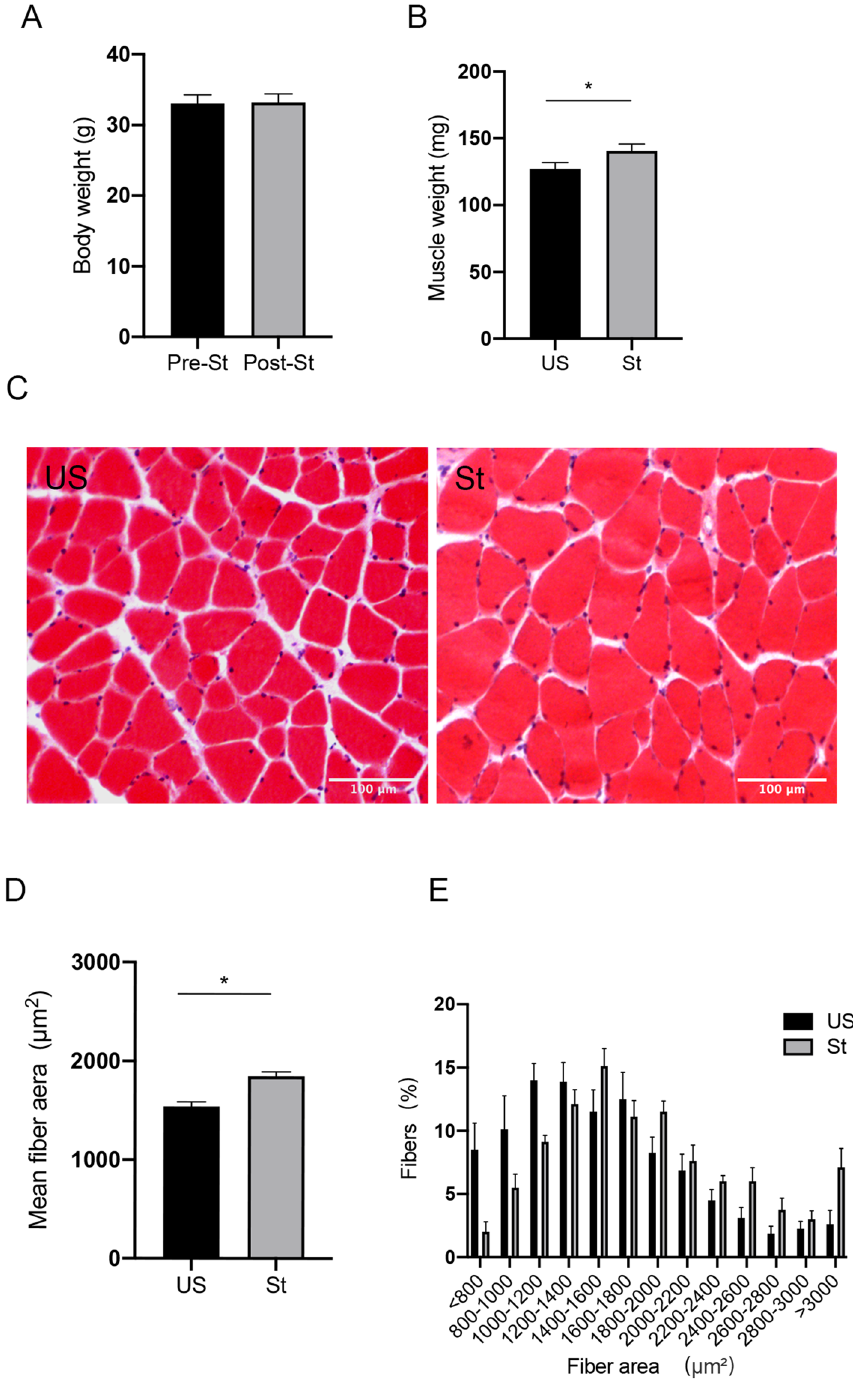
Figure 1. Body weight, muscle weight and fiber analysis ( A ) Body weight. ( B ) Mean weight of gastrocnemius muscle. ( C ) H&E staining of the gastrocnemius muscle. The bar indicates 100 μm. Magnification: ×100. ( D ) Mean cross-sectional fiber area of gastrocnemius muscle. ( E ) Frequency distribution of cross-sectional gastrocnemius muscle fiber area. US unstretched. St stretched. Values are expressed as mean ± SEM. *P < 0.05, n =